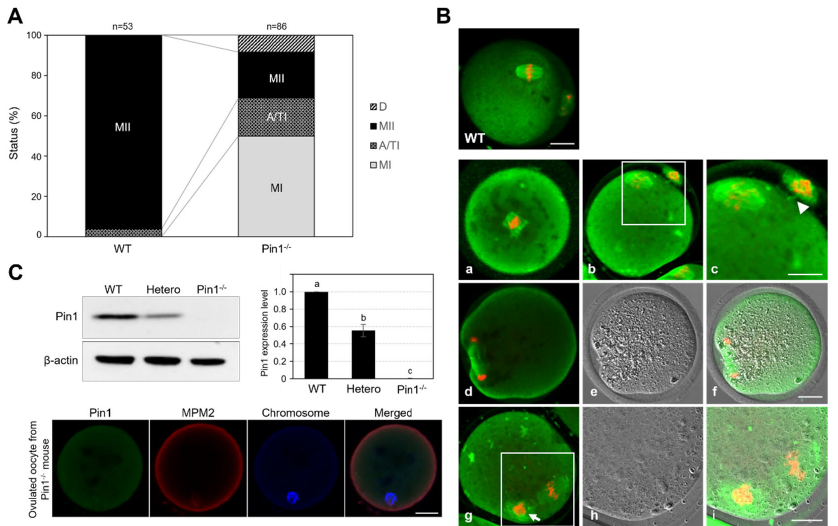
Figure 4. Most oocytes from Pin1 − / − mice did not show meiosis progression. ( A ) Graph showing the stages of ovulated oocytes determined by the localization of α‐ tubulin and nuclear status. MI, met ‐ aphase I; A/TI, anaphase/telophase I; MII, metaphase II; D, cell death. ( B ) Typical localization pat ‐ terns of α‐ tubulin and nuclei in Pin1 − / − oocytes. An image of oocytes collected from wild ‐ type (WT) mice is shown as a control. The oocytes from Pin1 − / − mice shown in panels ( a ), ( d ), and ( g ) are ar ‐ rested at MI or do not show proper extrusion of the first polar body. The oocytes shown in panel ( b ) show proper extrusion of the first polar body, but the polar body and the cytoplasm are not sepa ‐ rated, and the morphology of the spindles and chromosomes in the oocytes is not clear. Arrowheads indicate the cytoplasm. The inset in panel ( c ) is indicated by a white box in panel ( b ). Panel ( e ) shows a bright ‐ field image and ( f ) shows the bright ‐ field image merged with the fluorescence image from panel ( d ). Panels ( h ) and ( i ) are enlarged portions from panel ( g ), showing a bright ‐ field image and the bright ‐ field image merged with a fluorescence image, respectively. The inset is indicated by a white box in panel ( g ). Arrows indicate segregated chromosomes in the cytoplasm. Scale bar, 20 μ m. Green and red indicate α‐ tubulin and chromosomes, respectively. ( C ) Immunoblotting analysis of the expression of Pin1 in oocytes from WT, heterozygous, and Pin1 − / − mice; no expression of Pin1 is seen in oocytes from Pin1 − / − mice. The graph shows the levels of Pin1 normalized to that of β‐ actin. Immunofluorescence staining shows significantly reduced expression of Pin1 and phospho ‐ mitotic proteins detected using the anti ‐ MPM2 antibody in oocytes from Pin1 − / − mice. Green, red, and blue indicate Pin1, MPM2, and nuclei, respectively. Scale bar, 20 μ m. Data represent the mean ± SEM of three replicates repeated in different experiments. Different letters represent significant difference for p < 0.05.